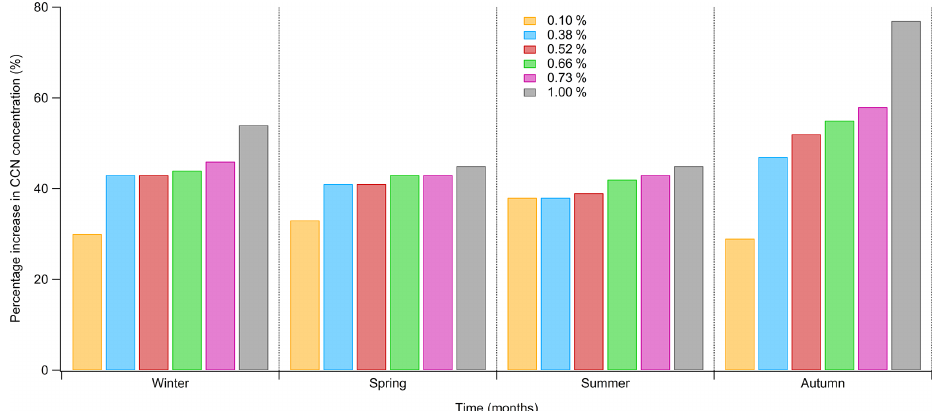
Figure 4. Seasonal variation in percentage increase regarding the estimated CCN concentrations for supersaturation 0.10% (orange bars), 0.38% (light blue bars), 0.52% (red bars), 0.66% (green bars), 0.73% (magenta bars), and 1.00% (grey bars) relative to the available 162 NPF days at Finokalia throughout the period June 2008–May 2015.